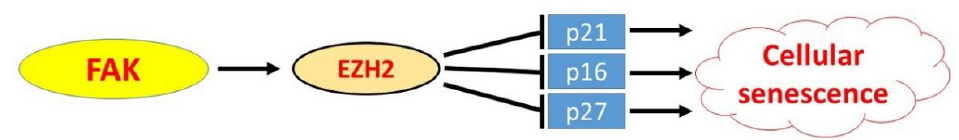
Figure 6. FAK executes anti-senescence via regulating EZH2 signaling. A proposed mechanism shows that FAK suppresses cellular senescence through strengthening the EZH2-mediated repression of cyclin-dependent kinase inhibitors in non-small cell lung cancer cells.